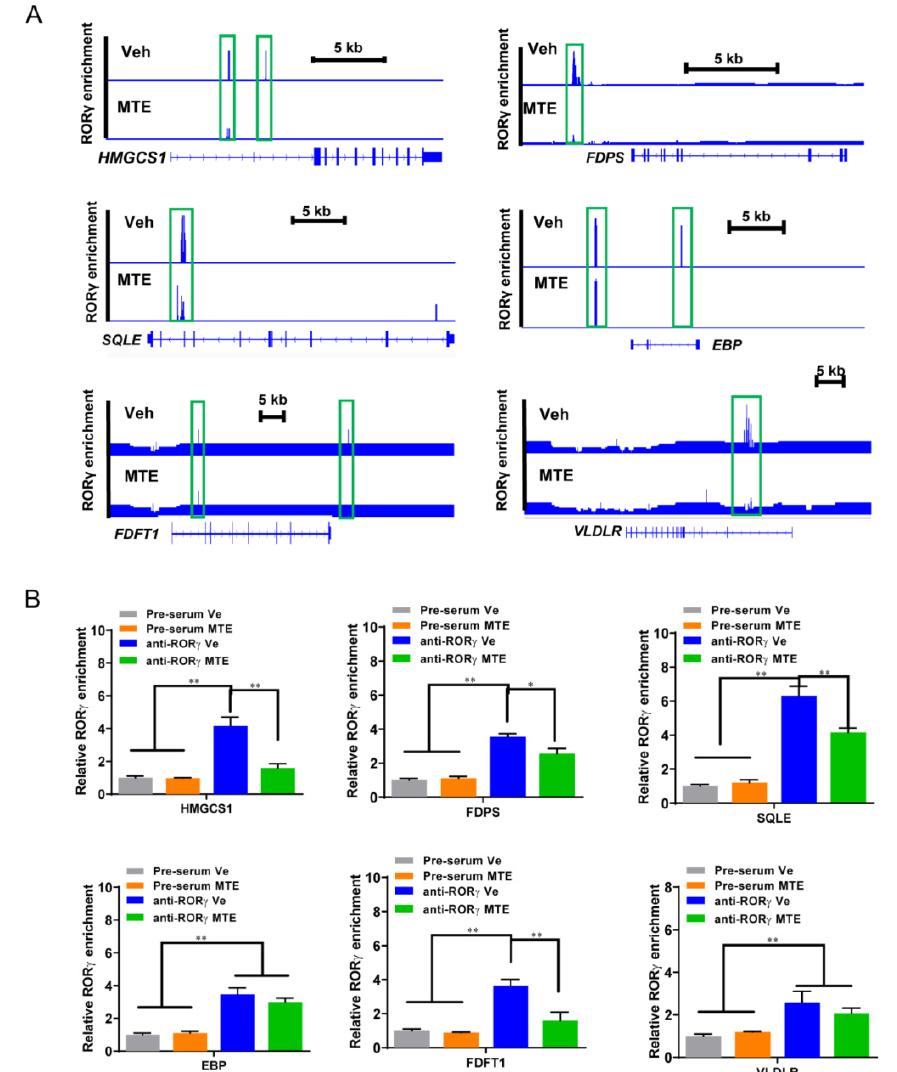
Figure 6. Loss of ROR γ binding at the enhancers and promoters of cholesterol metabolic genes. ( A ) Signal visualization of ROR γ ChIP-seq at indicated cholesterol metabolism genes. ( B ) ChIP-qPCR analysis of hepatic ROR γ binding in control or mycotoxin piglets. The data are shown as the means ± SD, n = 3. The experiments were repeated three times. * p < 0.05, ** p < 0.01.